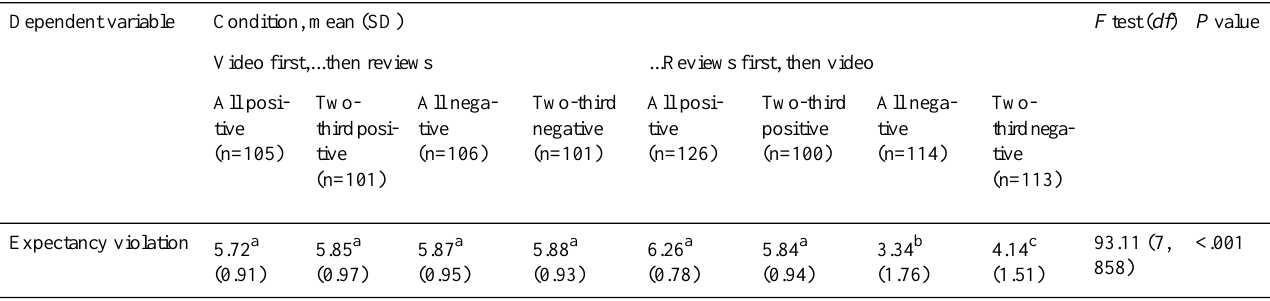
Table 1. Expectancy violations by